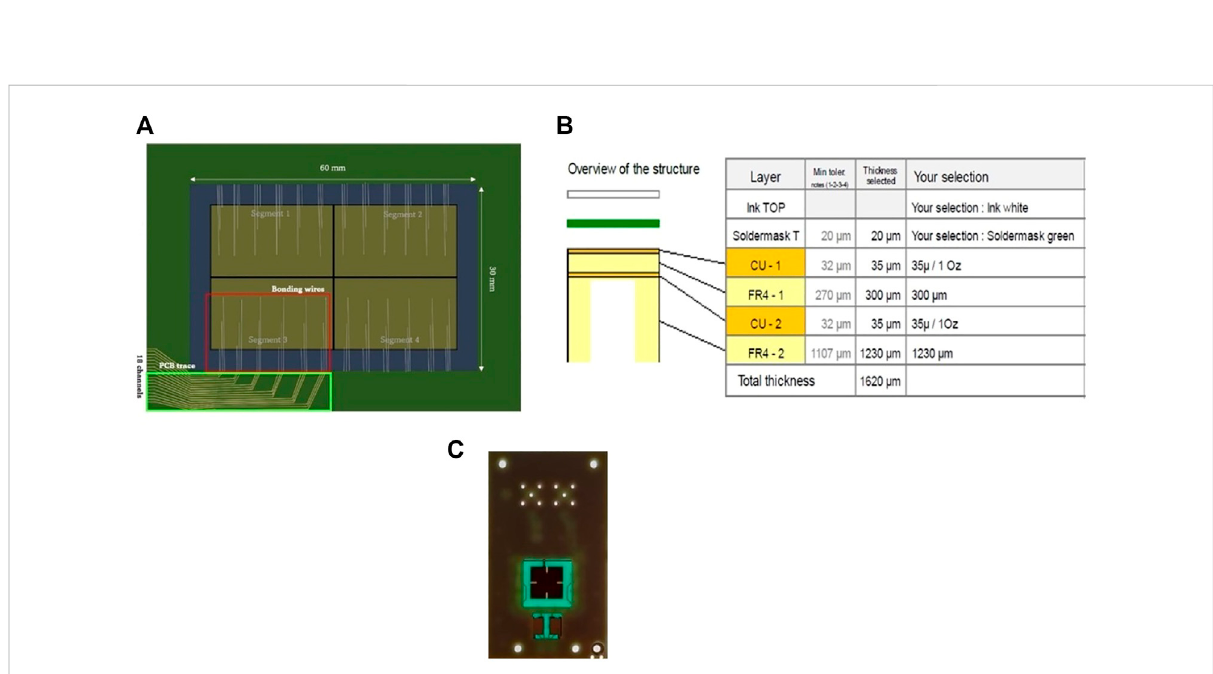
FIGURE 4 (A) Preliminary bonding scheme of the full detection layer, covering an active area of 30 mm × 60 mm. (B) Cross section of the chosen layer stacking for the detector holder that minimizes the material budget along the beam path. (C) Photograph of the mini-carrier developed for a 1 cm 2 active area detector prototype. The reduced thickness area is evident as transparent to